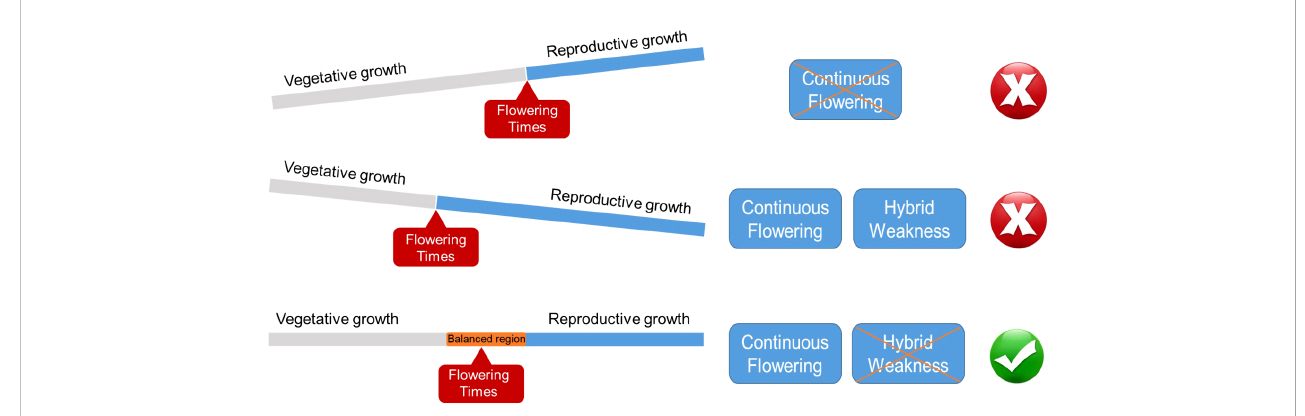
FIGURE 6 Breeding target model for continuous fl owering and hybrid weakness balancing vegetative and reproductive growth. A suitable balance point is to be con fi rmed to ensure the target fl owering time under the normal growth